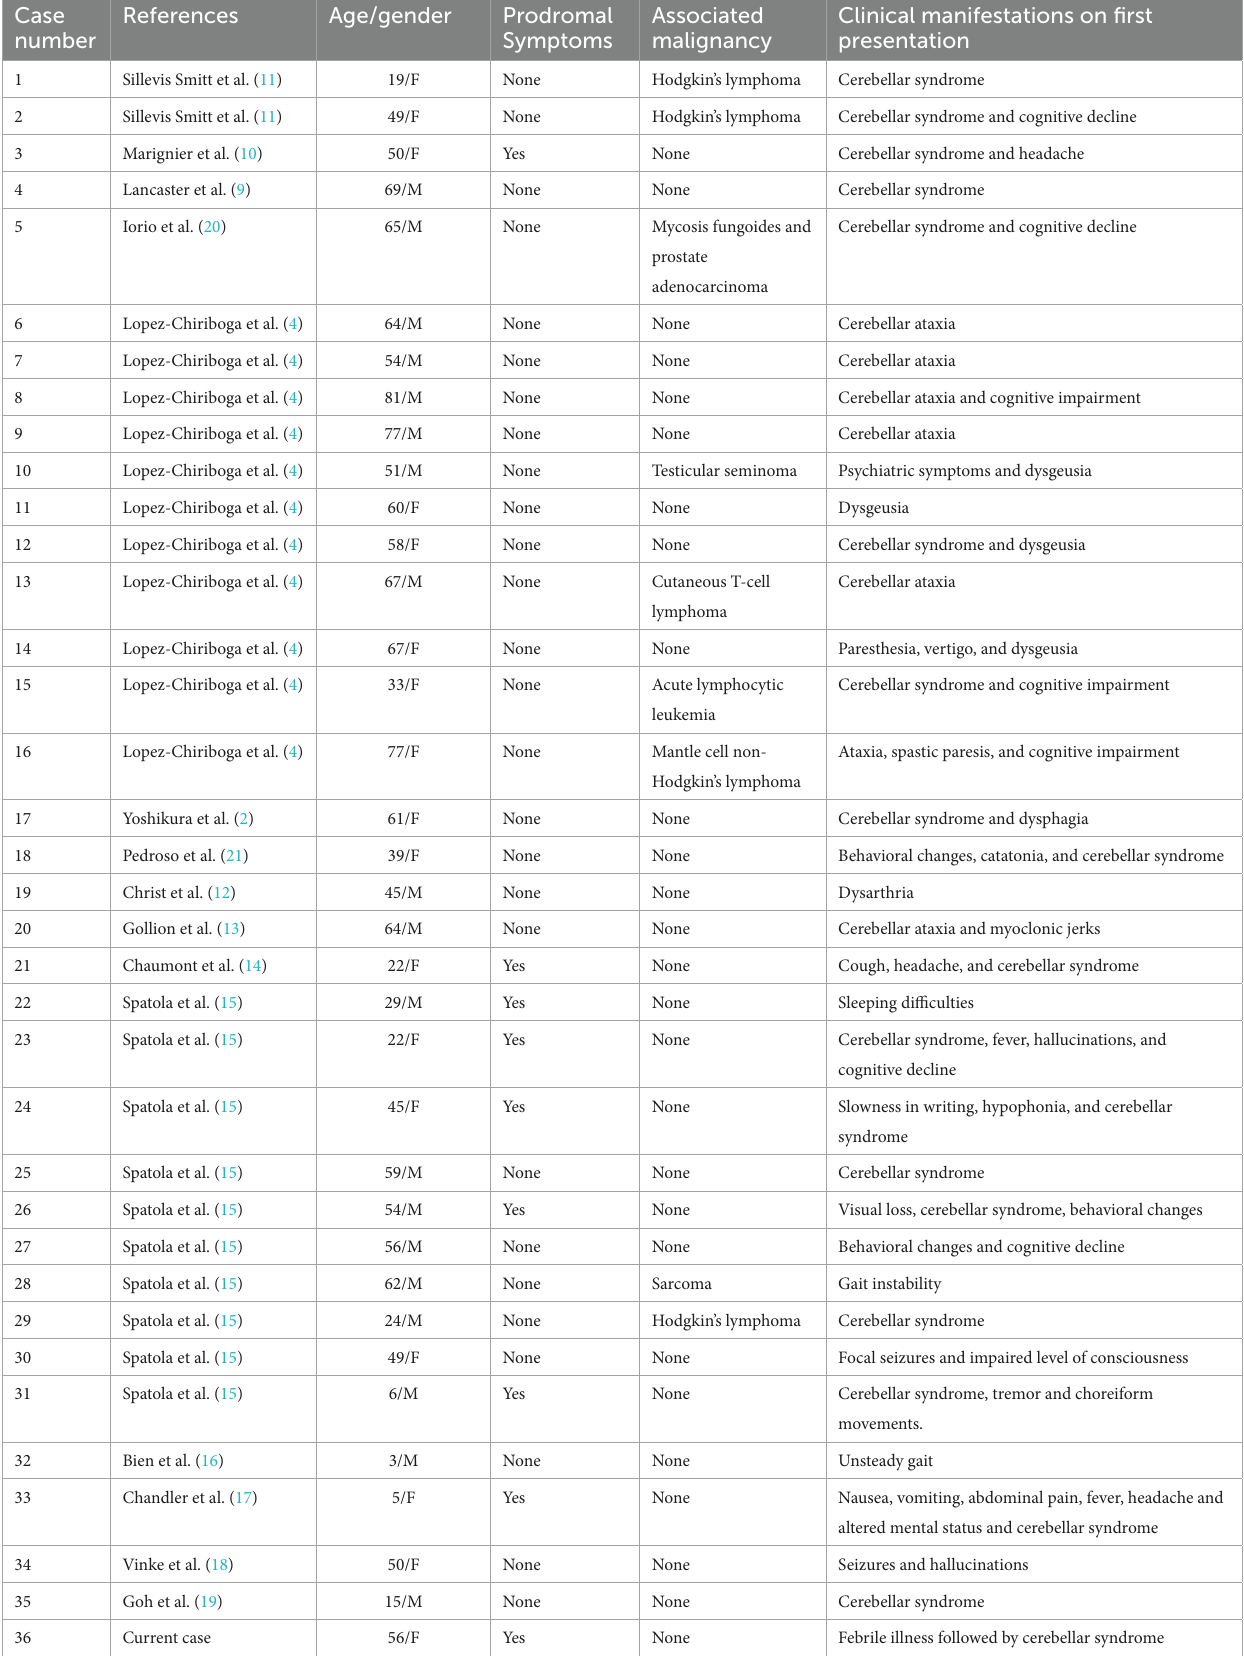
TABLE 1 Demographic features and clinical manifestations on first presentation of 36 patients diagnosed with anti-mGluR1 encephalitis. Case